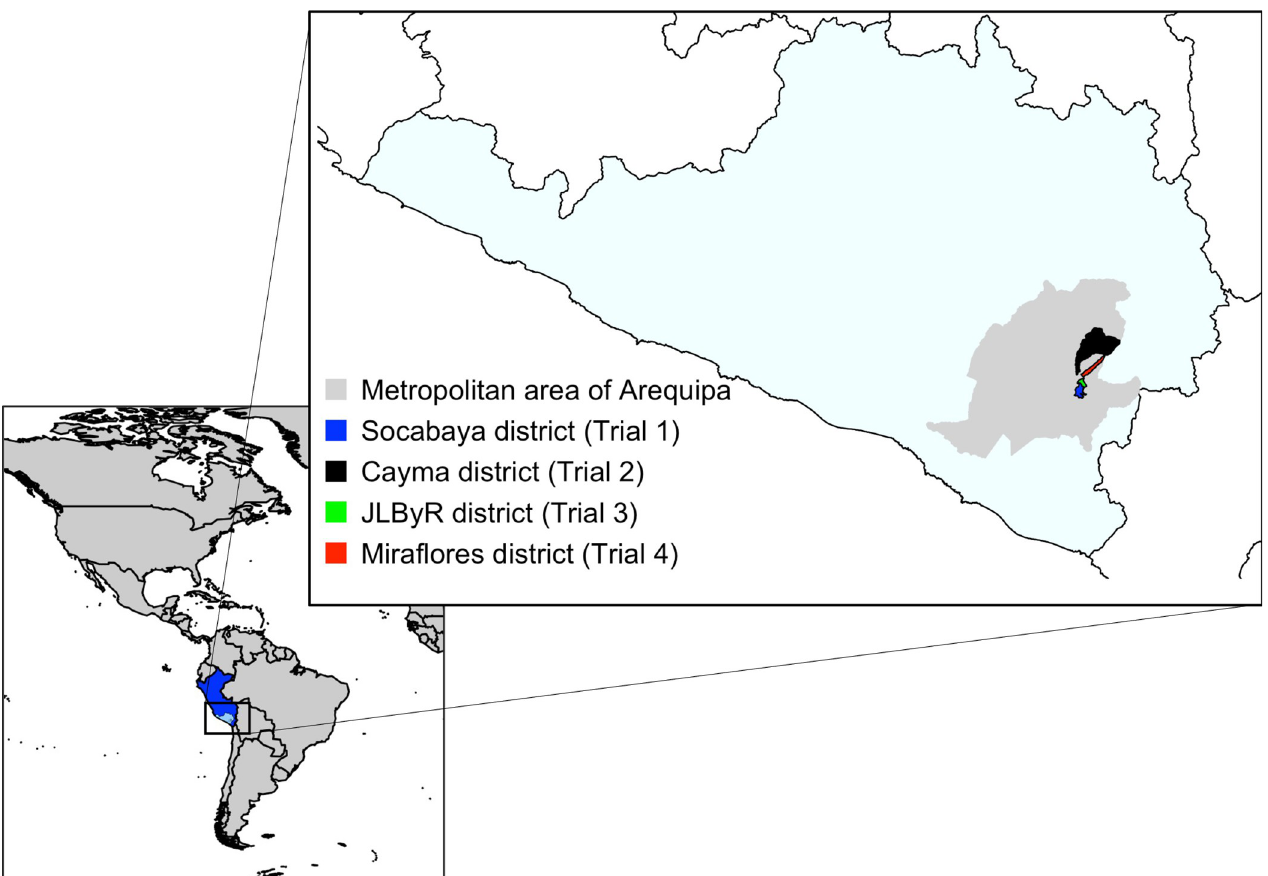
Fig 1. Map of study sites. Left: Western hemisphere with Peru shown in dark blue and the state of Arequipa in light blue. Right: Zoomed in map of the city of Arequipa (gray) and the study sites highlighted as described in the color-coded legend. The hemisphere map was created in R using the “maptools” package and the object “wrld_smpl,” which contains simplified world country polygons based on NASA data available on the NASA public Github page under ‘World- Wind-Java’ (https://github.com/nasa/World-Wind-Java/tree/master/WorldWind/testData/shapefiles). The Arequipa map was generated using our data.